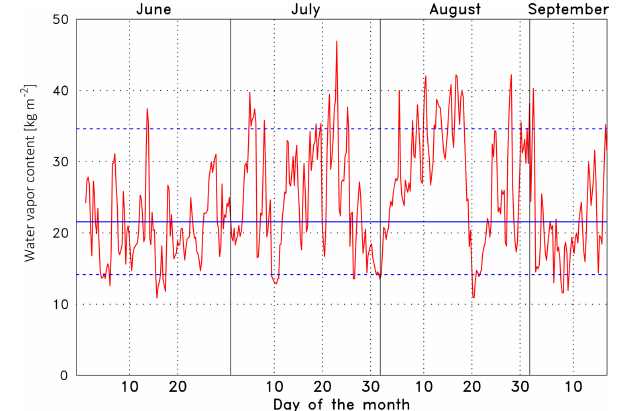
Figure 8. Total water vapor content (precipitable water) w in kgm − 2 for each radiosonde ascent during the CeiLinEx2015 cam- paign. The horizontal lines indicate the median (21.6kgm − 2 , solid) and the 10th percentile (14.1kgm − 2 ) and 90th percentile (34.7kgm − 2 ,